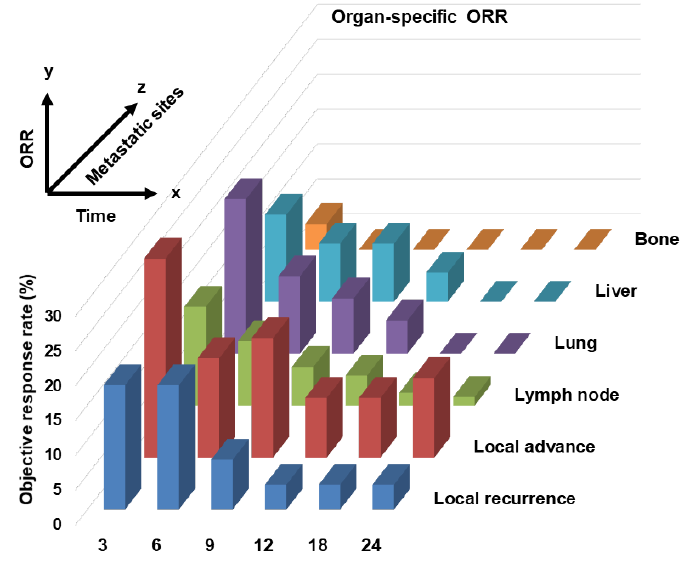
Figure 3. Changes in organ-specific objective response rate (ORR) over time. A three-dimensional image of the passage of time on the x-axis, ORR on the y-axis, and each lesion (local recurrence, local advance, lymph node, lung, liver, and bone) on the z-axis.